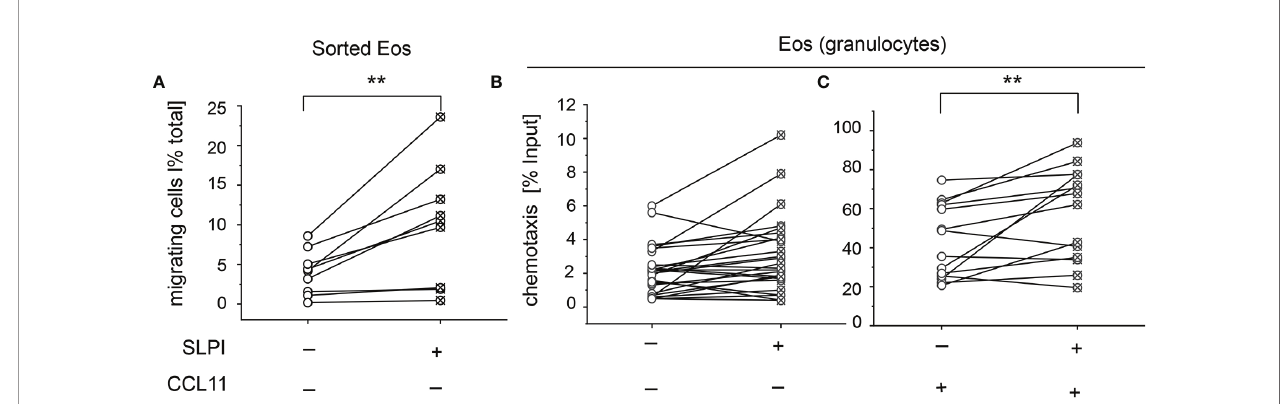
FIGURE 5 | Exogenous SLPI impacts eosinophil migration capacity. The cells indicated were derived from healthy donors and incubated with media supplemented with 10% FCS (-) or media supplemented with 10% FCS and 20 m g/ml SLPI for 15 min followed by migration assays. (A) Time-lapse video microscopy showing % of migratory cells in total cells per FOV, n = 9. **p < 0.001; t -test. (B) Transwell chemotaxis assay to media only, n = 17; (C) Transwell chemotaxis assay to 50 ng/ml CCL11, n = 10. Symbols indicate individual donors and lines connect data sets from the same individuals. **p < 0.001; Mann – Whitney